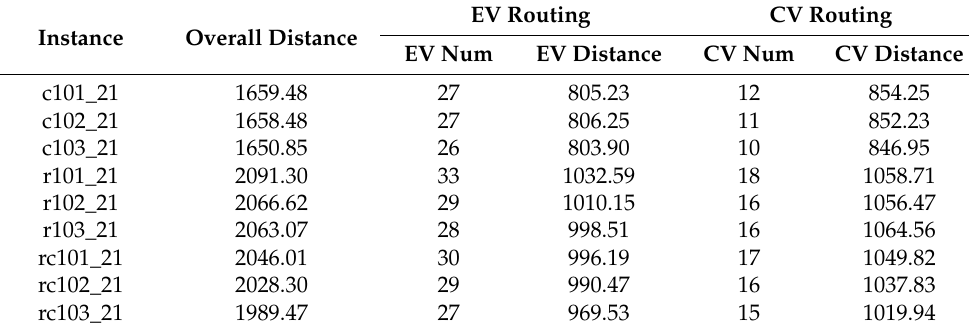
Table 6. Results of two-phase approach on large-size